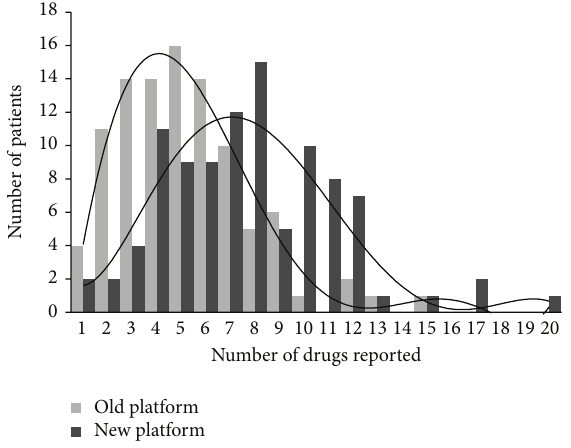
Figure 3: Distribution of qualified hits across 99 retrospective patient samples used for clinical validation. The reference platform reported up to 15 drugs per patient while the new platform reported up to 20 drugs per patient. On an average, the reference platform reported 3–5 patients per sample while the new platform reported 6–8 patients per sample.